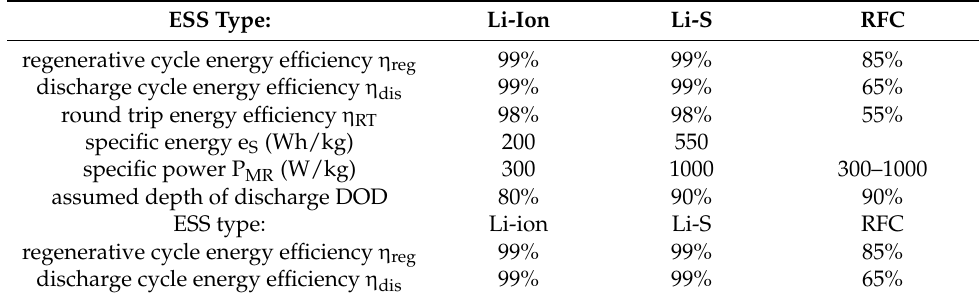
Table 8. Notable properties of the studied energy storage